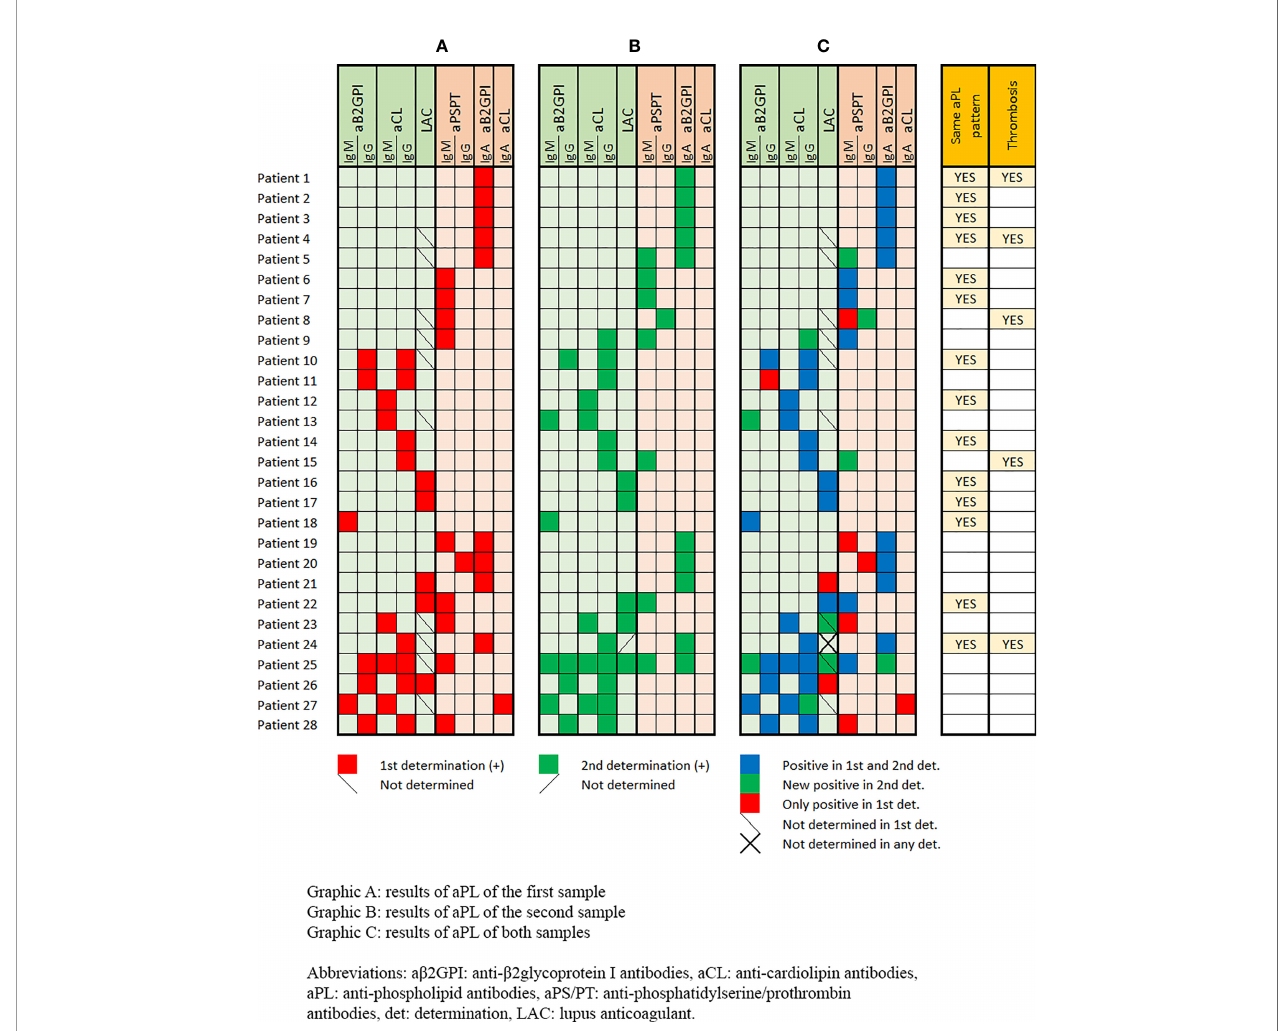
FIGURE 1 | Antiphospholipid antibodies (criteria and non-criteria) pro fi le in the fi rst blood sample (Graphic A ), in the second blood sample (Graphic B ), and in both samples (Graphic C ) of the 28 patients who were positive at both